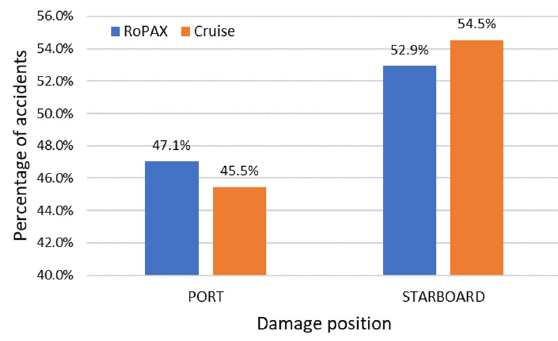
Figure 16 . Transverse distribution of damage breaches .